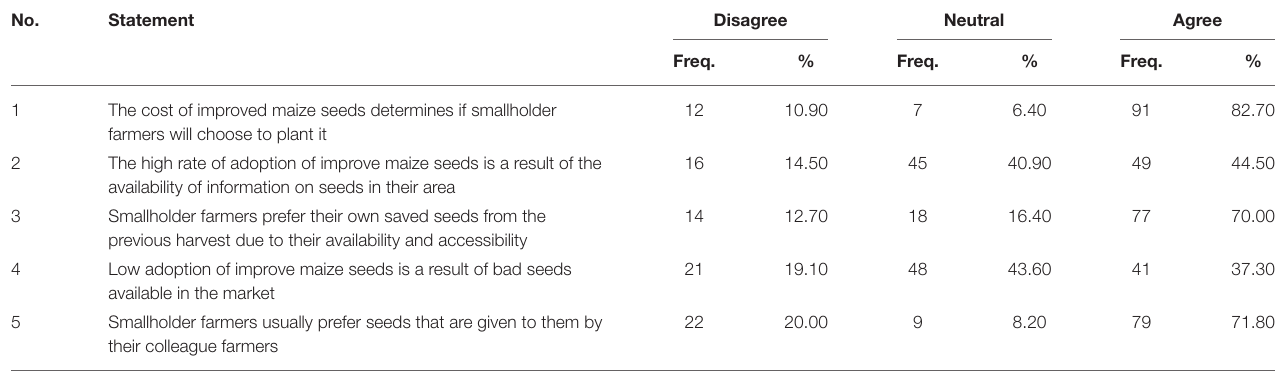
TABLE 5 | Determinant of improved maize seeds adoption among smallholder farmers. No.